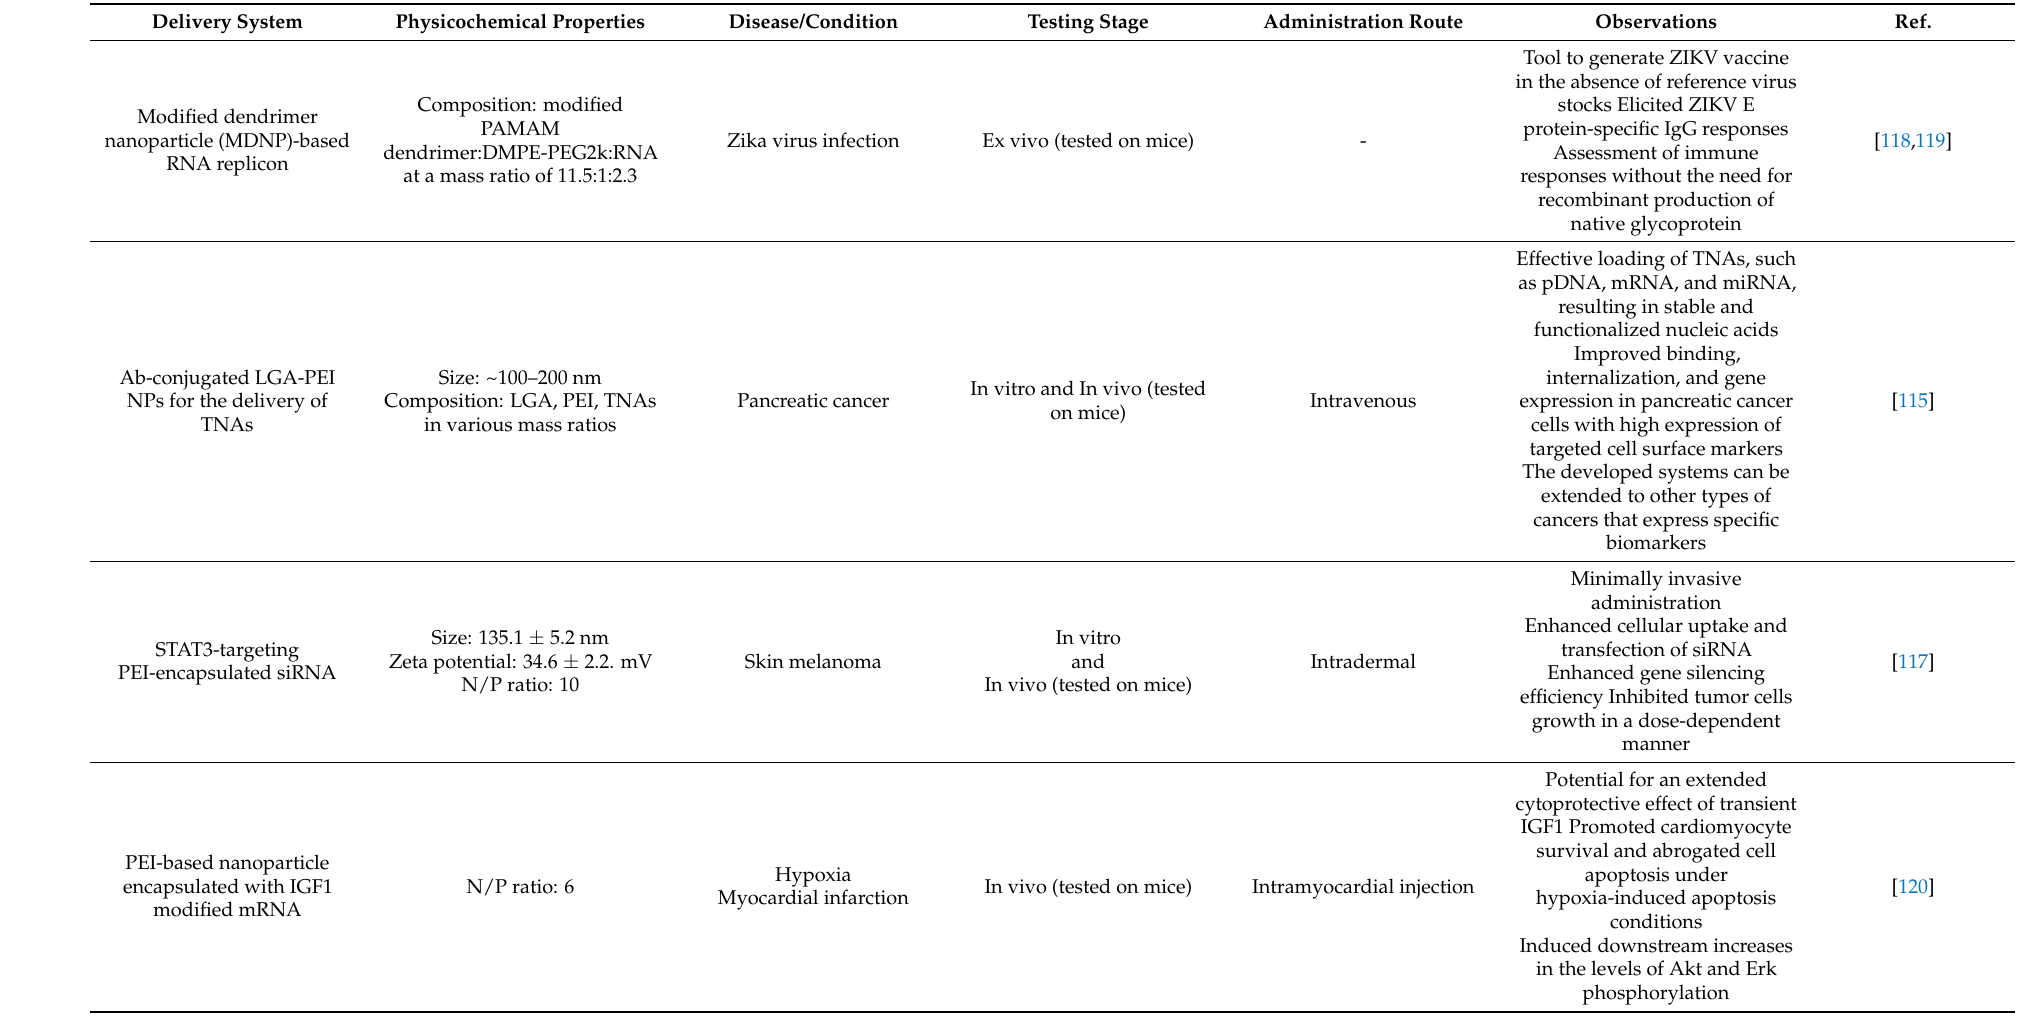
Table 2. A summary of polymer-based nucleic acids delivery systems